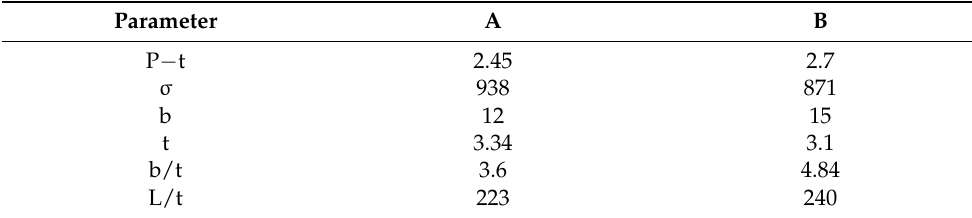
Table 3. Optimum spring parameters .